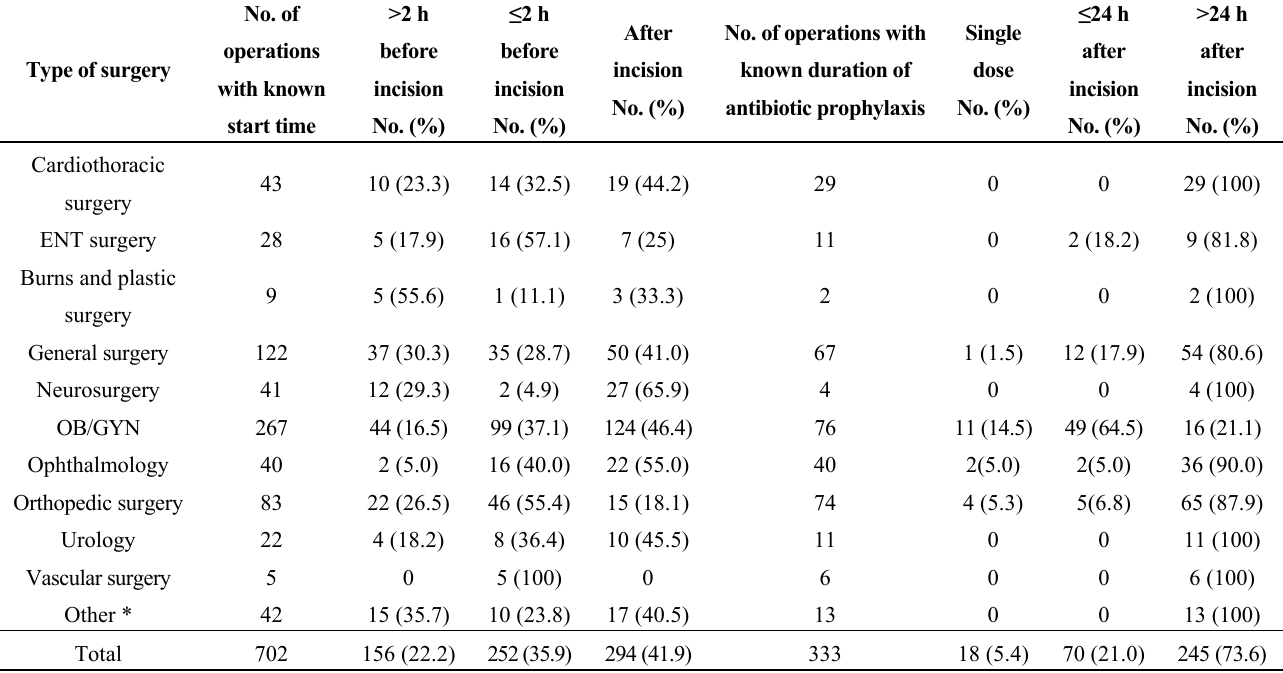
Table 4. Timing of First Dose and Duration of Surgical Antibiotic